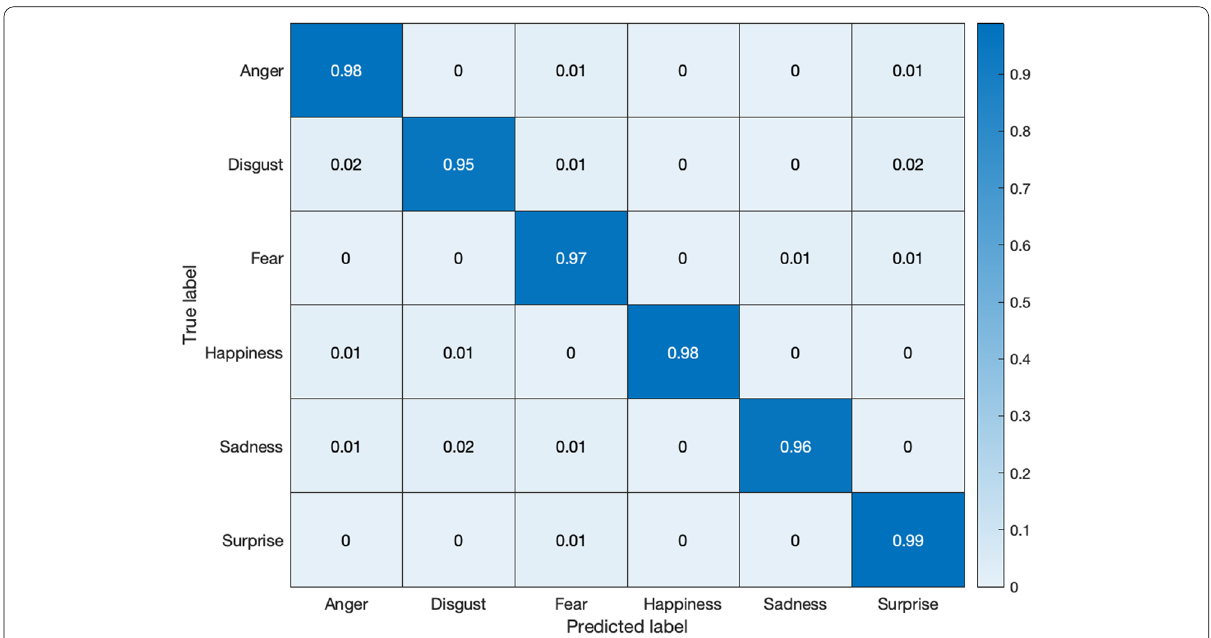
Fig. 16 Confusion matrix of facial expressions in BP4D-Spontaneous datasets